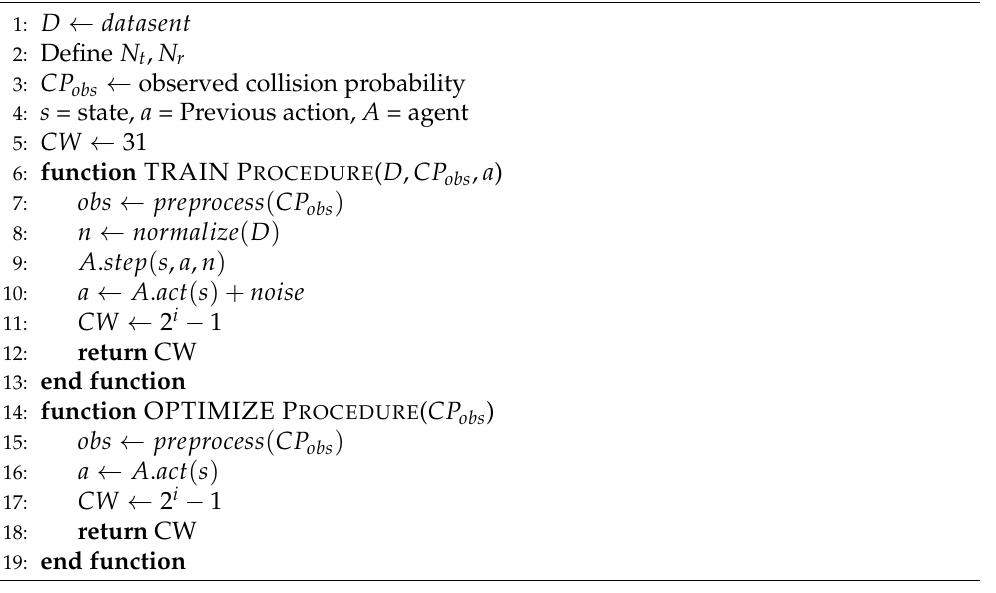
Algorithm 1 DRL Based Contention Window Optimization (DCWO)